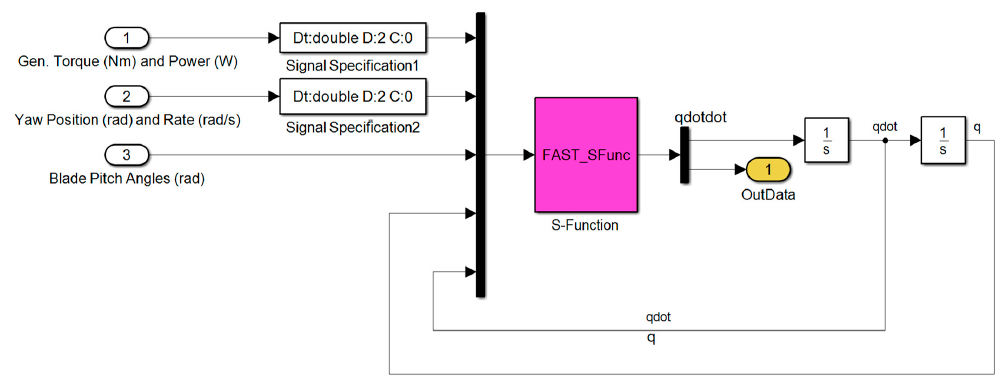
Figure 8. The FAST S-Function Block.